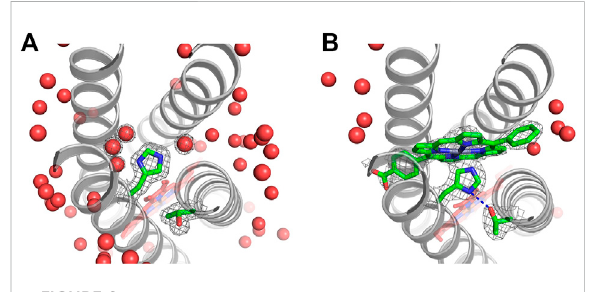
FIGURE 9 Structure of P -site with and without pigment bound. The (F obs , φ calc )electrondensityisshownat1.0 σ contouringforHis124, Thr77, and the pigment or water molecules in the P -site. (A) The 1.45 Å resolution crystal structure without a pigment bound includes four water molecules in the P -site (PDB ID: 5VJT). (B) A 2.0 Å resolution crystal structure with pigment ZnPCP at 70% occupancy reveals that upon pigment binding, the P -site widens slightly and water molecules are removed from the binding site (PDB ID: 5VJS). A blue dashed line indicates a hydrogen bond between Thr77 and His124 with 2.7 Å between heavy